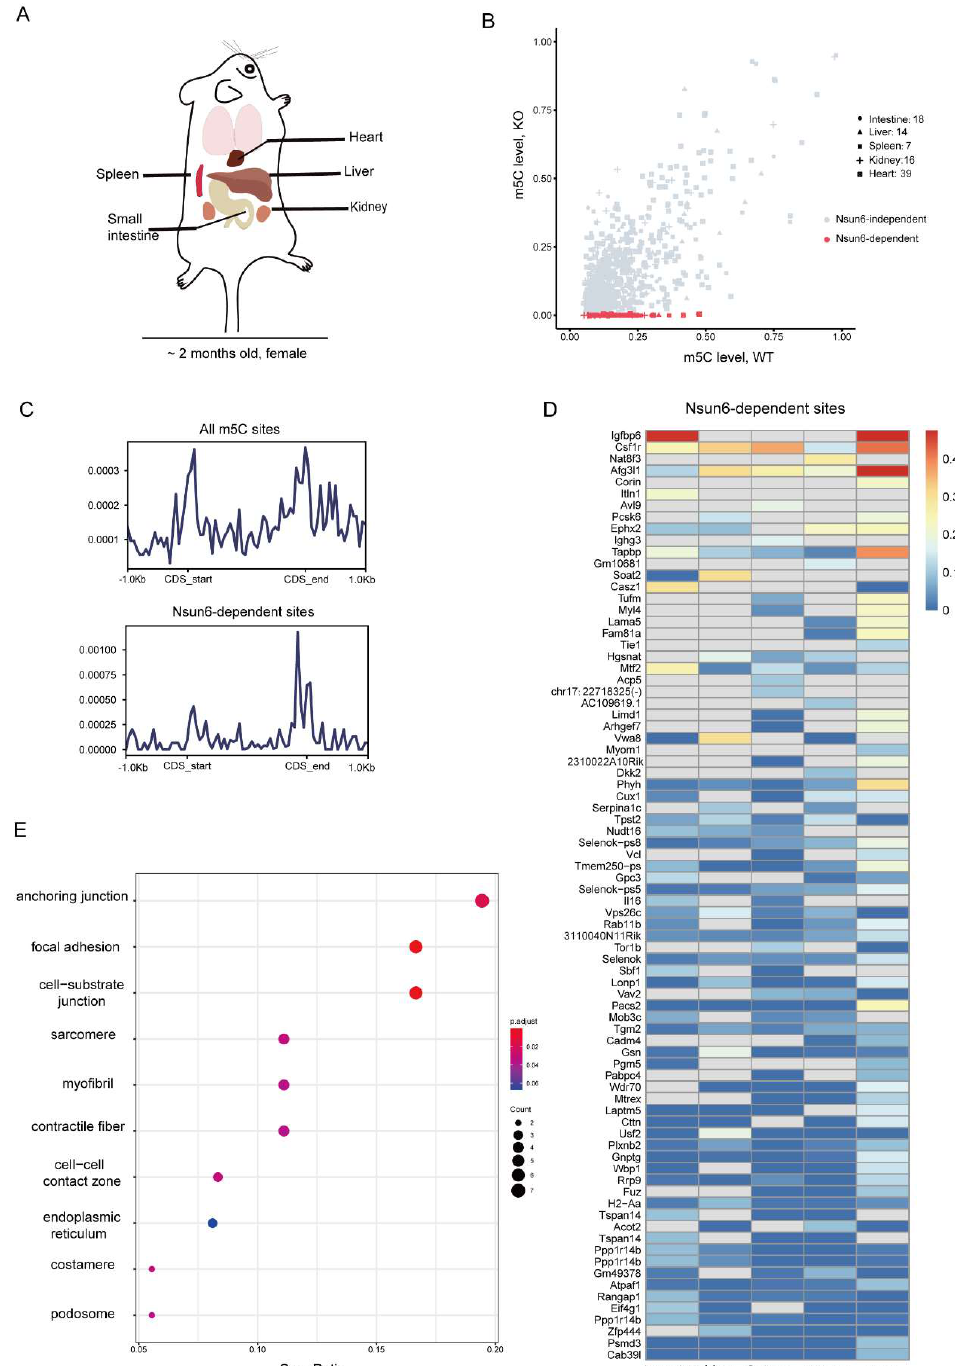
Figure 2. Identification of high-confident Nsun6-dependent m5C sites across tissues. ( A ) Five tissues (small intestine, liver, spleen, kidney, and heart) were used to perform BS-seq ( n = 2). ( B ) The scatter plot presents the modification rate of m5C sites in different tissues. Red dots represent Nsun6- dependent sites. ( C ) The distribution of total and Nsun6-dependent m5C sites along with mRNA. ( D ) Heat map showing the modification rate of Nsun6-dependent sites across tissues. Undetected sites were represented by the gray block. ( E ) GO analysis of genes with Nsun6-dependent m5C sites in the heart